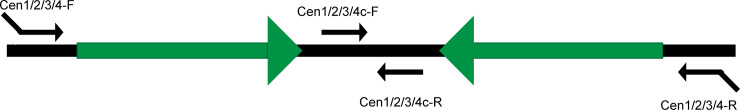
Strategy for the amplification of K. phaffii centromeres.Schematic representation of a typical K. phaffii centromere. Inverted repeats are represented by green arrows. Primer annealing regions are shown by black arrows.